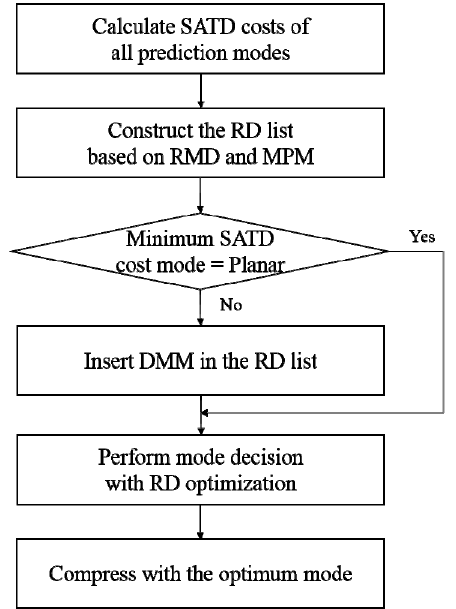
Figure 2. Flowchart of the original depth intra mode decision method in 3D-HEVC.